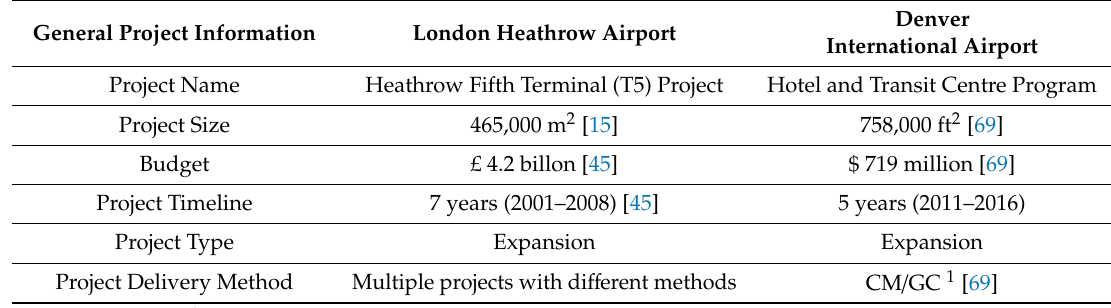
Table 7. General information on the selected projects for data triangulation.